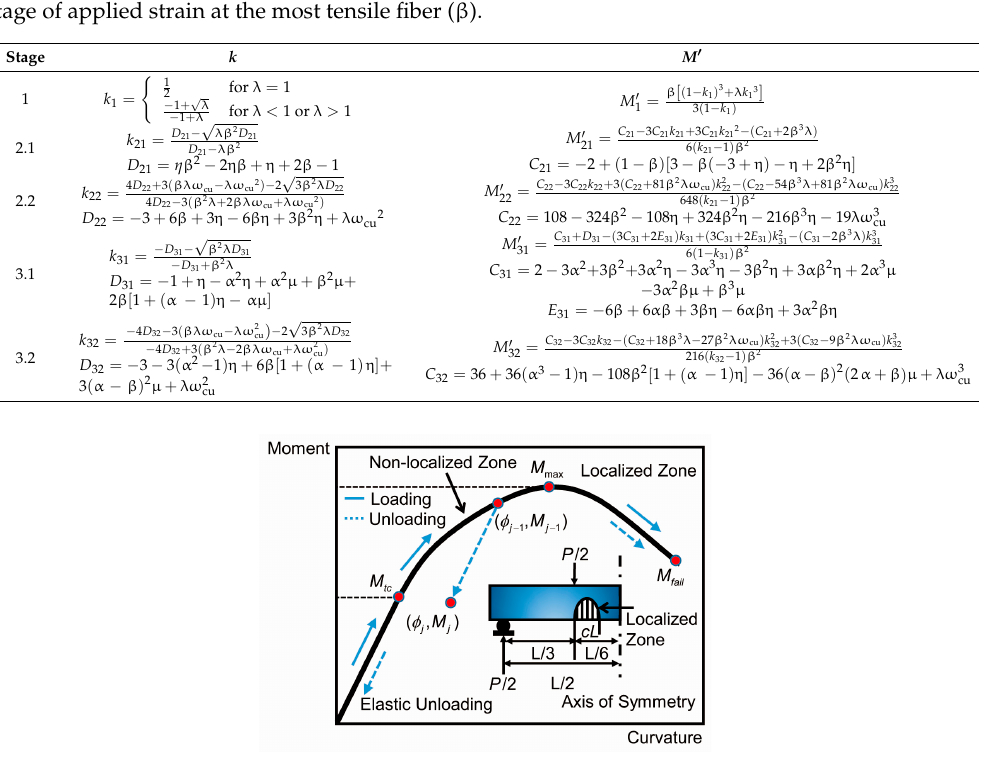
8 of 14 Table 3. Solutions of the neutral-axis depth ratio and normalized moment, and the curvature for each stage of applied strain at the most tensile fiber ( β ). Stage